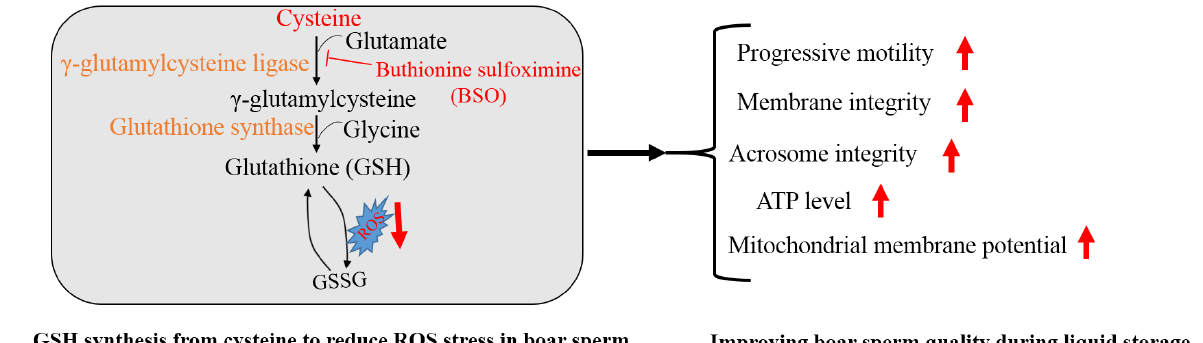
Figure 8. Mechanisms of cysteine involved in regulating boar sperm quality. Boar sperm could utilize the cysteine to generate GSH for reducing the ROS stress, thus improving sperm quality. BSO, buthionine